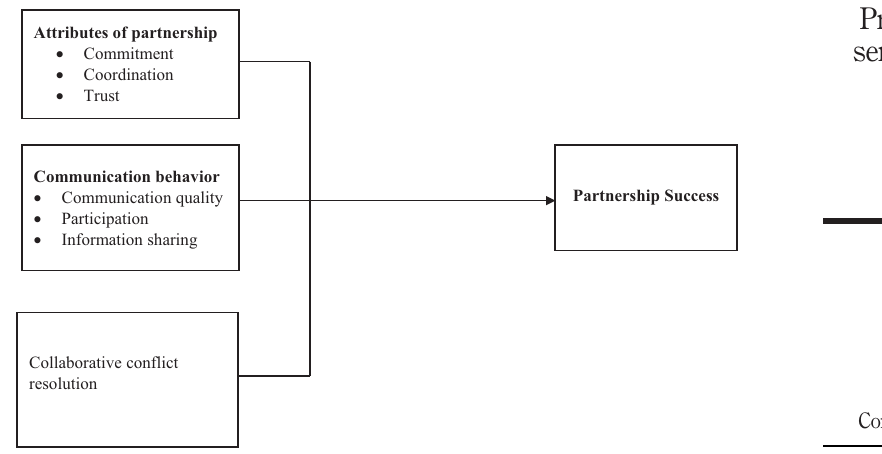
Figure 1. Conceptual